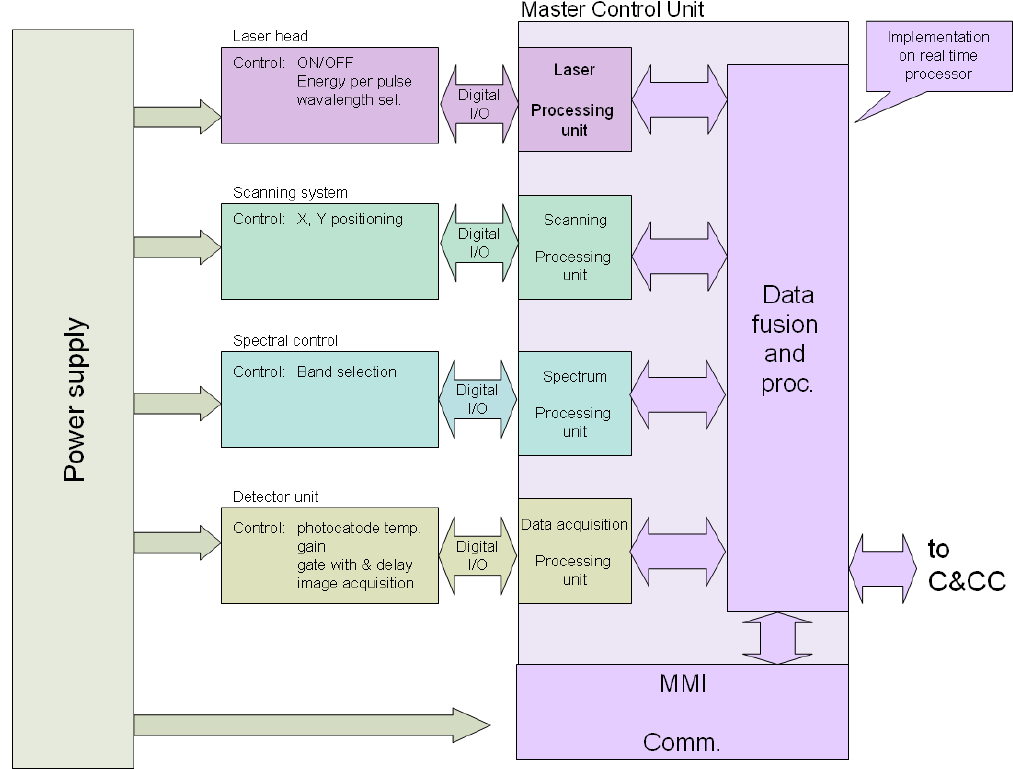
Figure 3. General layout of the LIF sensor.